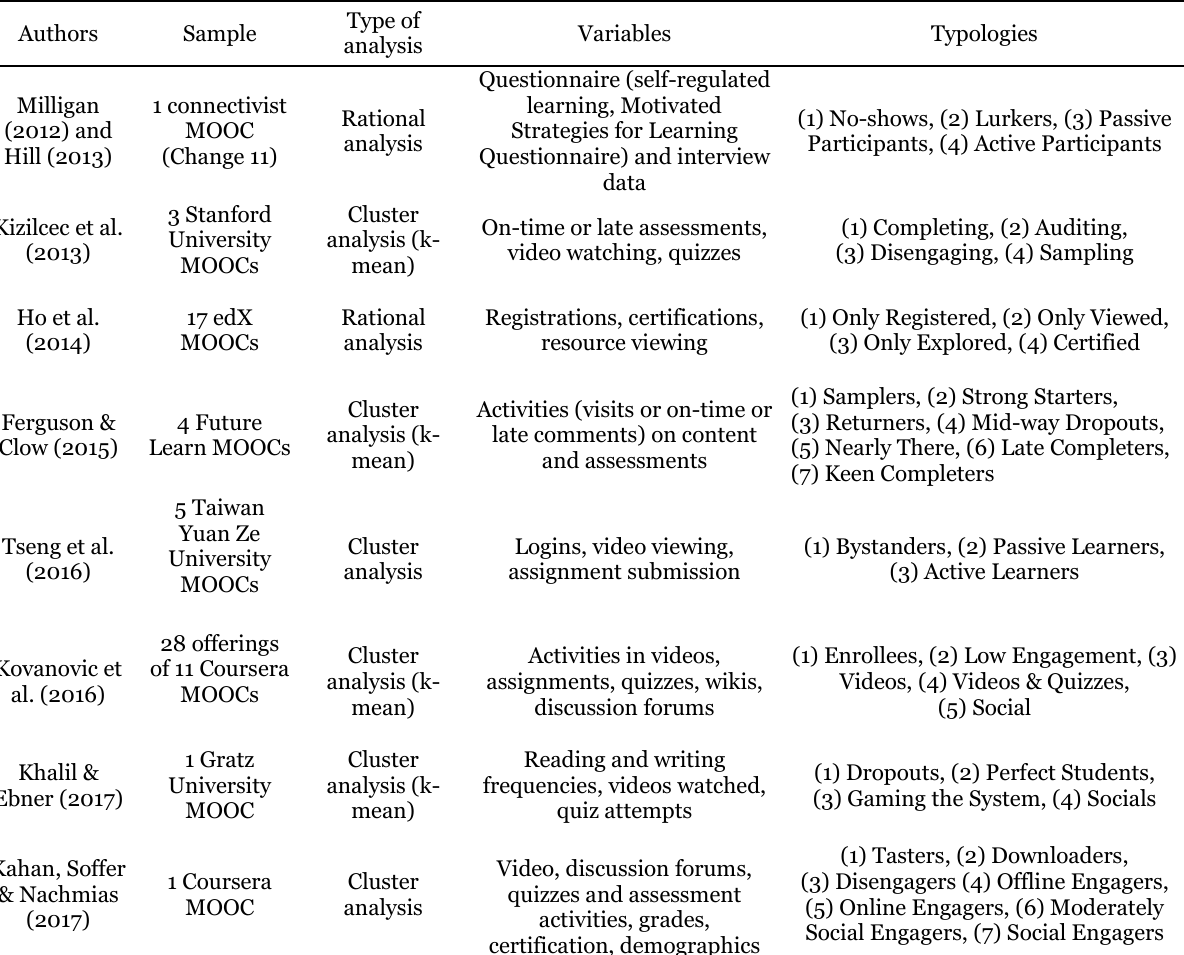
Literature Review on MOOC Participant Typologies in Chronological